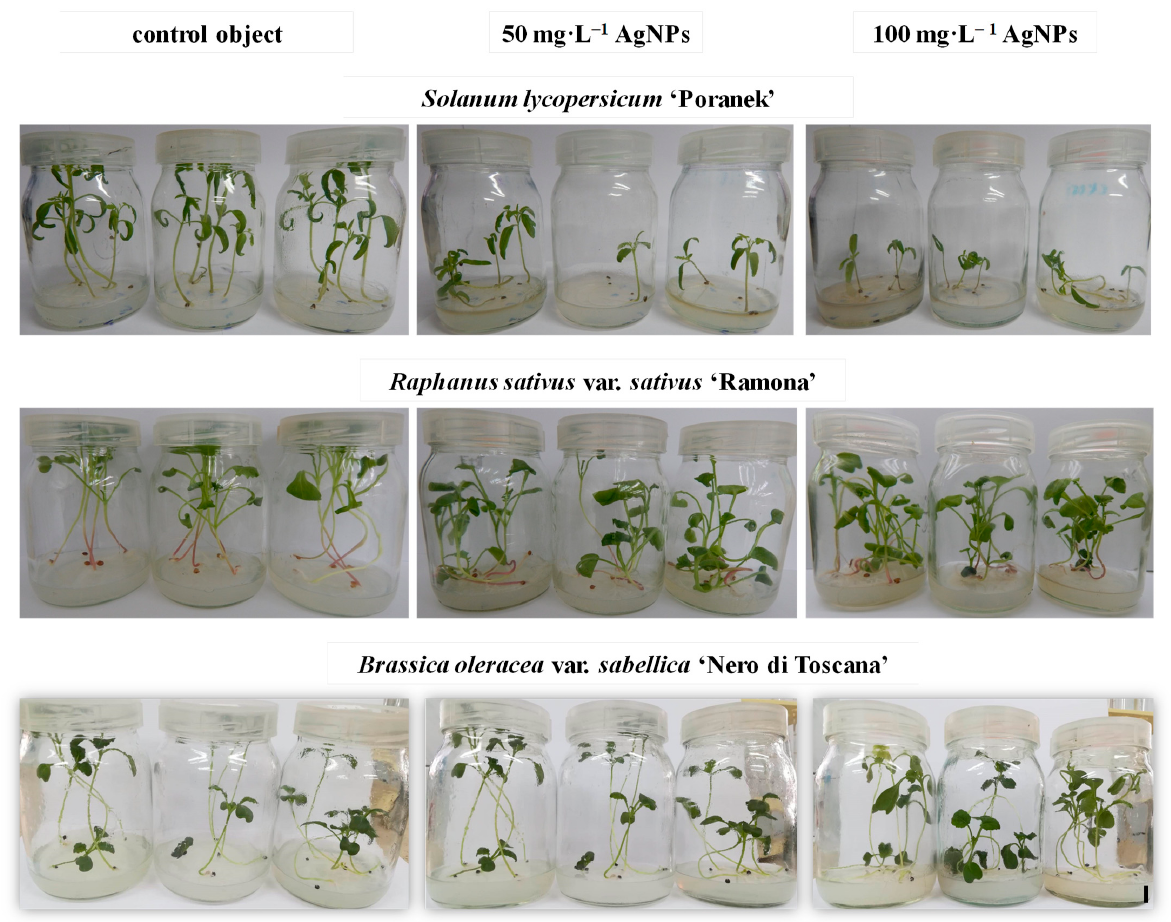
Figure 3. Developed seedlings of the tested vegetable plant species cultured in vitro for three weeks on the modified MS medium depending on the AgNPs treatment. Bar = 1 cm.